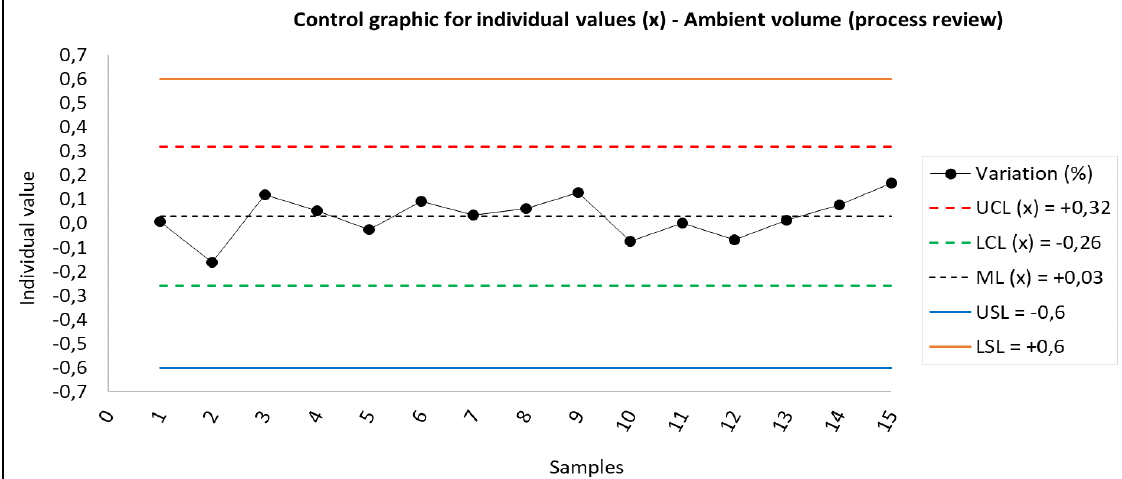
Figure 9: Control chart of individual values ( x ) - Ambient volume (process review). Source: Authors, (2020).